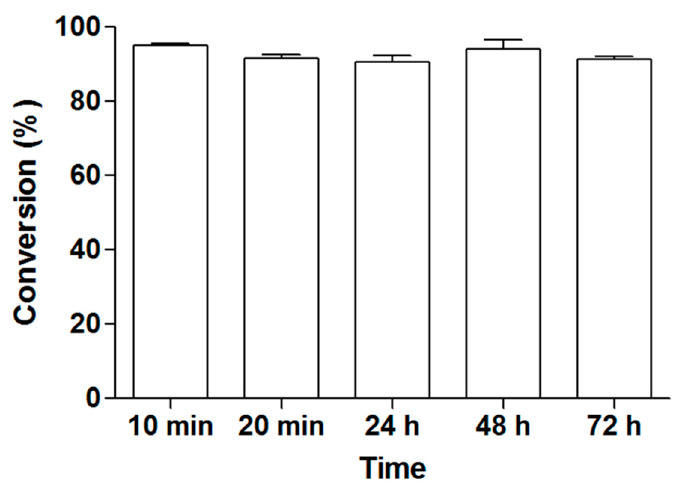
Figure 6. Continuous packed bed reactor with Novozym ® 435 to synthesize 2-PEAc. The reaction was carried out for 3 days at an enzyme amount of 10,000 propyl laurate units (PLU), a 2-PE concentration of 257 mM, a flow rate of 1 mL min − 1 and reaction temperature of 56 °C.